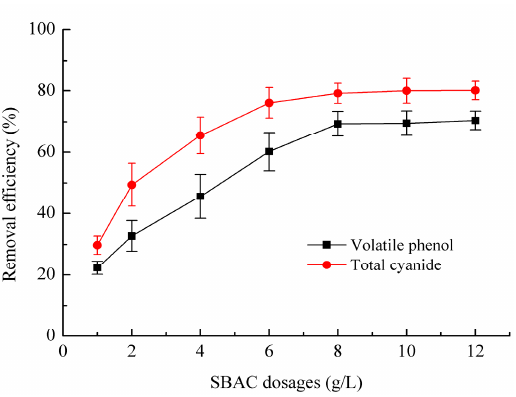
Figure 6. Effects of SBAC dosages on the removal efficiencies of volatile phenol and total cyanide. Error bars represent the range of data from duplicate experiments.